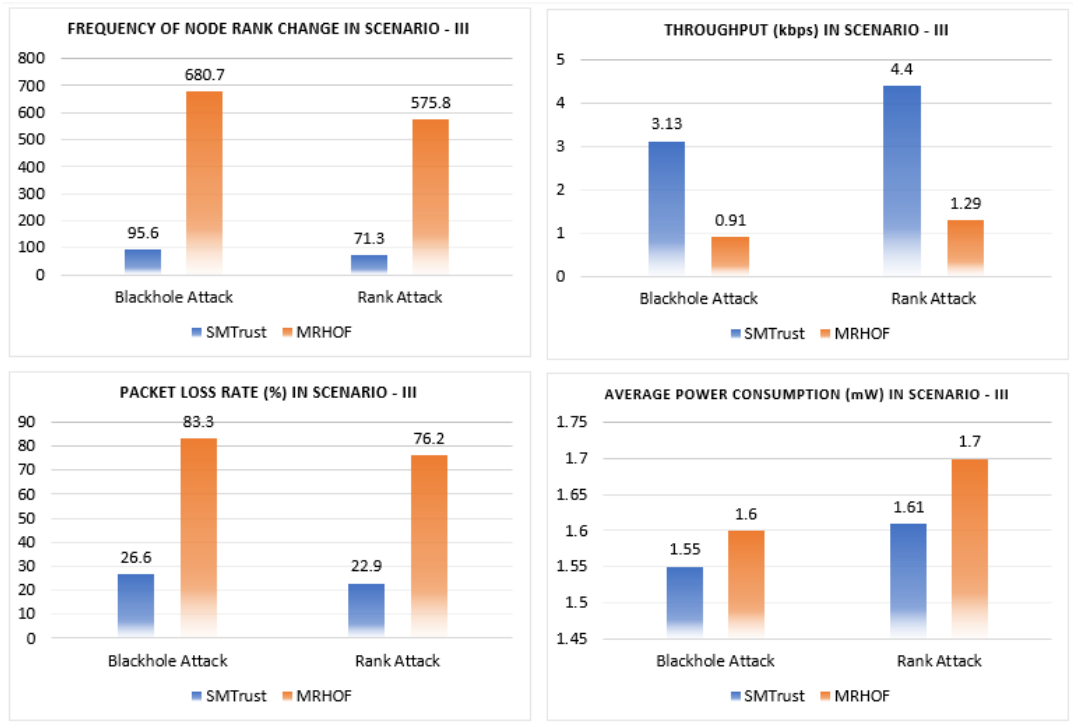
Figure 8. Results comparison of network performance under Blackhole and Rank attack in Scenario III.